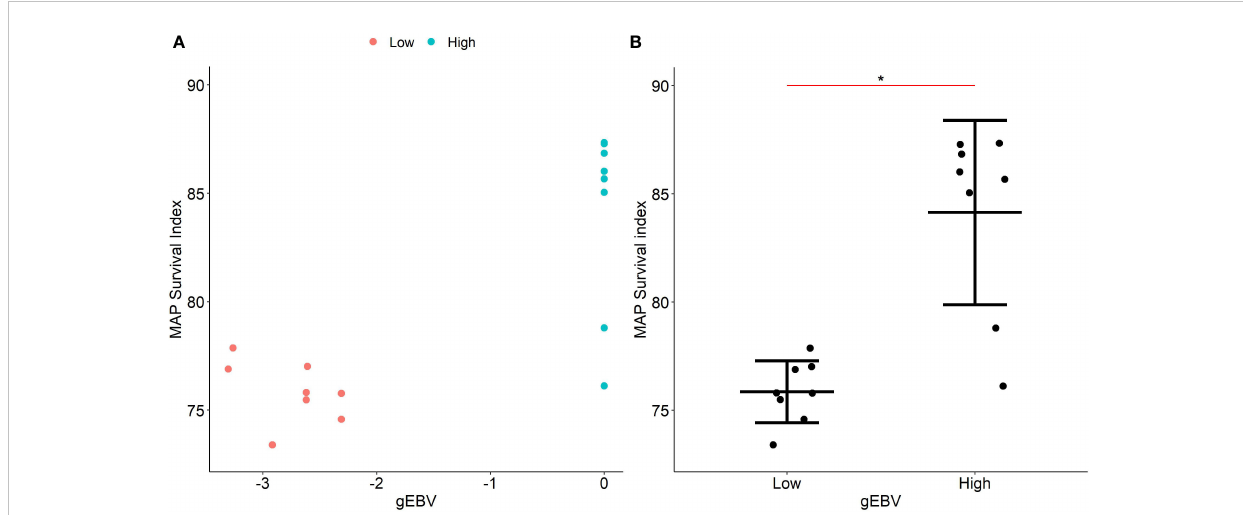
FIGURE 4 Validation of the gEBVs for MAP survival indexes within infected MDMs. (A) . Scatter plots showing the distribution of the gEBVs for MAP survival within infected MDMs for the validation population. gEBVs for MAP survival indexes within MDMs were calculated for each animal in the study population using a gBLUP model and the genomic predictions were validated in a validation population consisting of animals with high (N= 8) and low (N= 8) gEBVs. (B) . Experimental MAP survival indexes within MDMs from the validation population. MDMs from animals with high (N= 8) and low (N= 8) gEBVs were isolated, infected with MAP for 2 h and 7 d p. i., and the MAP survival indexes were calculated. Differences in the MAP survival indexes between animals with high and low gEBVs were statistically signi fi cant ( P< 0.0006). In the validation population, the correlations between the experimental MAP survival indexes within MDMs and the gEBVs were positive (Pearson r = 0.78, P = 0.0003). The asterisk indicates statistically signi fi cant